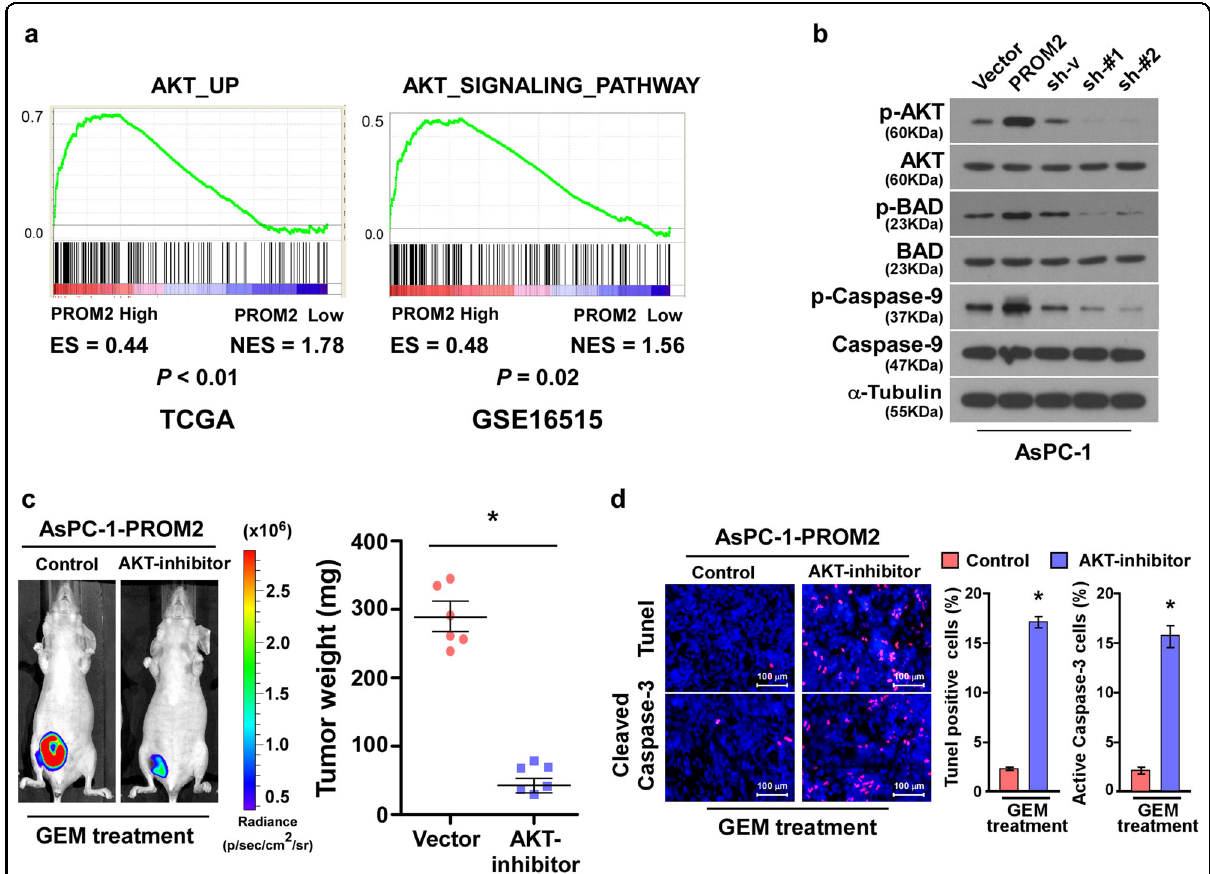
Fig. 5 PROM2 activates the Akt signaling pathway. a GSEA analysis showing the positive correlation between PROM2 expression and gene sets relevant to the Akt signaling pathway. b Immunoblotting assays demonstrating the expression level of the indicated proteins in AsPC-1 cells with different expression level of PROM2. c Luminescence signaling (left) and tumor weight (right) of the tumors formed by AsPC-1/PROM2 after treatment with vehicle or the Akt inhibitor (MK-2206) (* P < 0.05). d Representative images (left) and quanti fi cation (right) of TUNEL and active caspase-3 in tumors with the indicated treatment (* P <